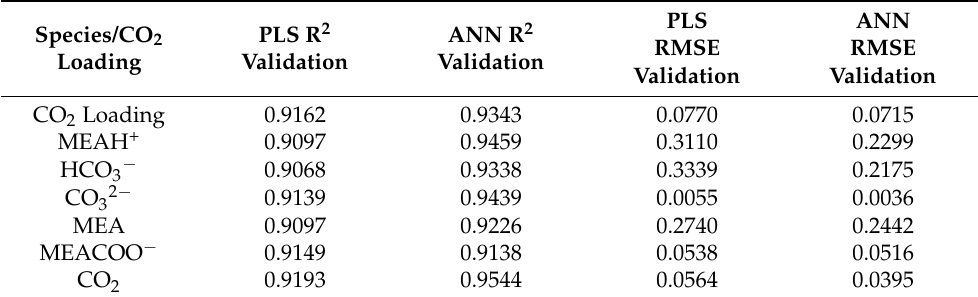
Table 5. Comparison between average values of the performance parameters between PLS and ANN